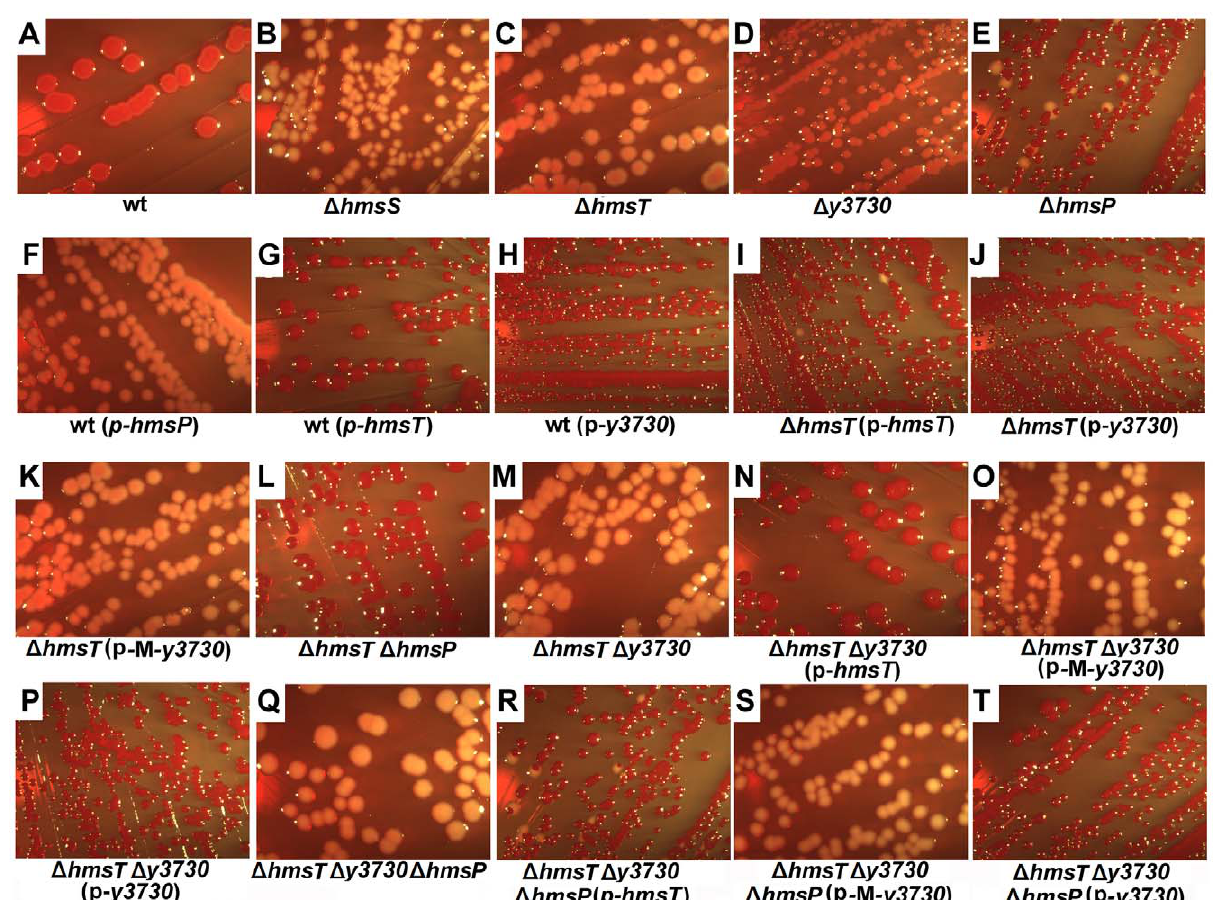
Figure 1. Pigmentation phenotype of Y.pestis strains on LB-Congo red agar. See text and Table 3 for description of the strains.